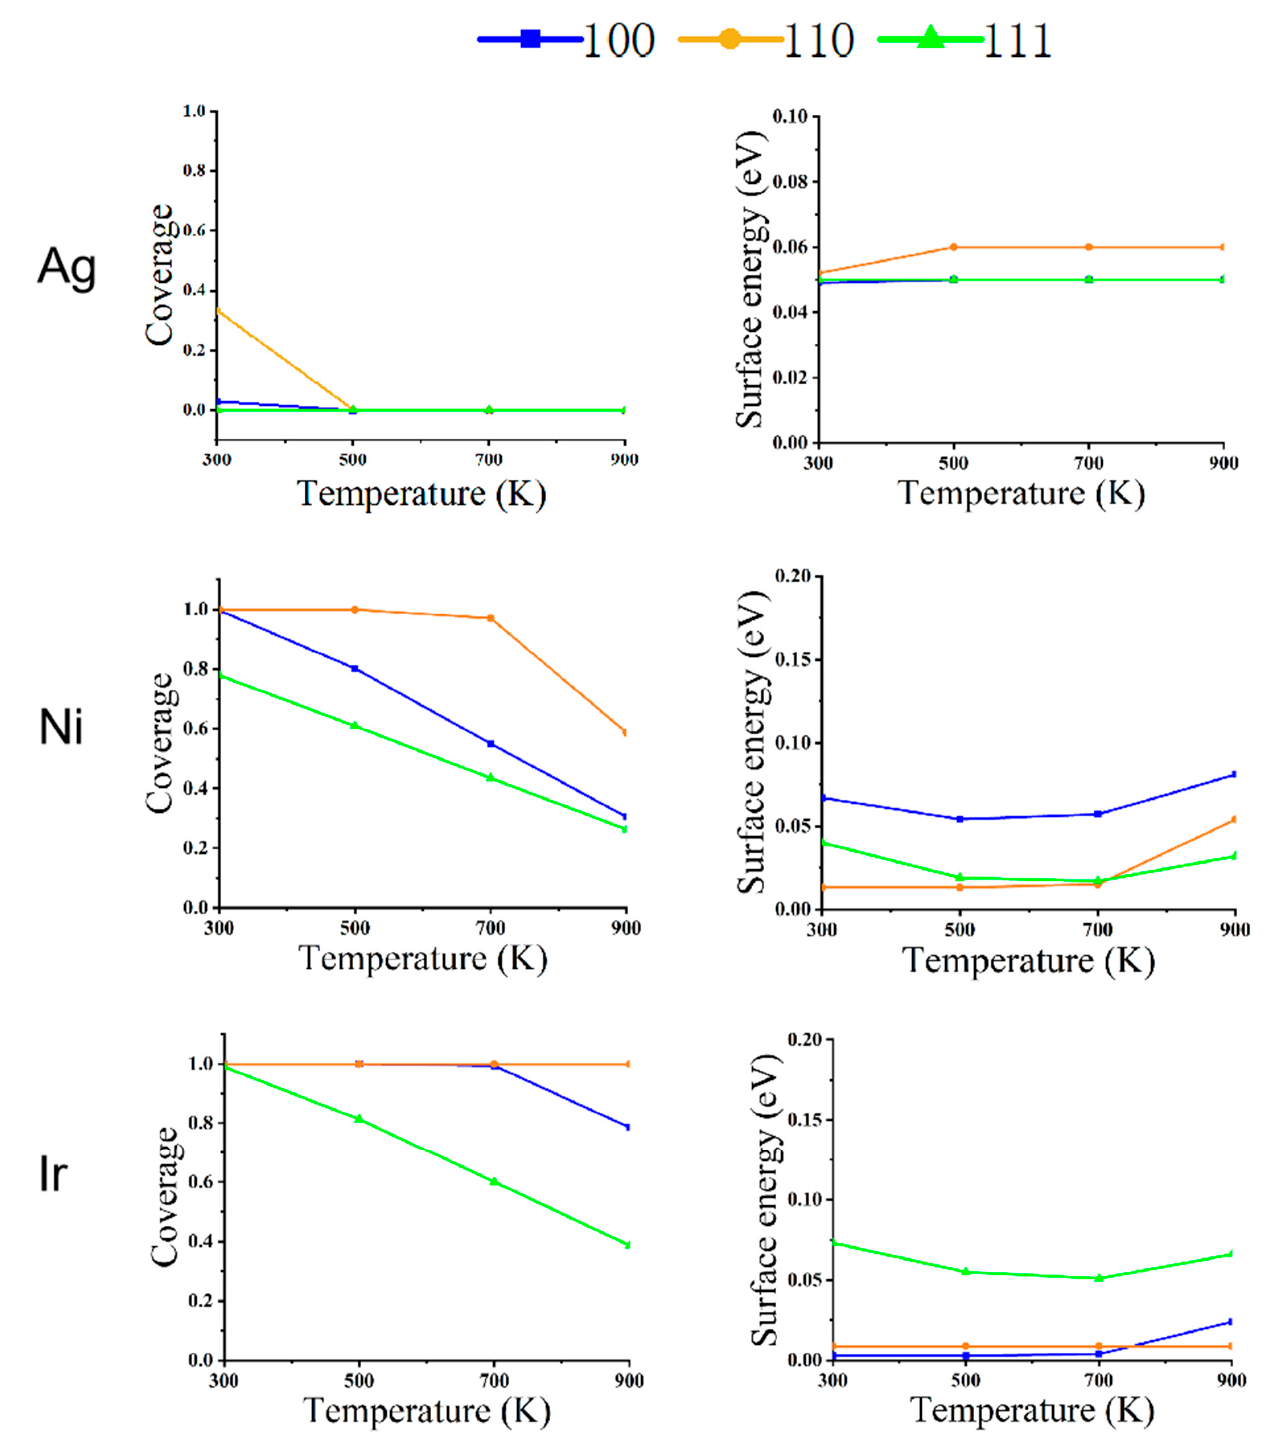
Figure 6. The relationship between CO coverage ( left ) and surface energy ( right ) in different faces of metal NPs (Ag, Ni, and Ir) at changing temperatures and a pressure of 1 bar.